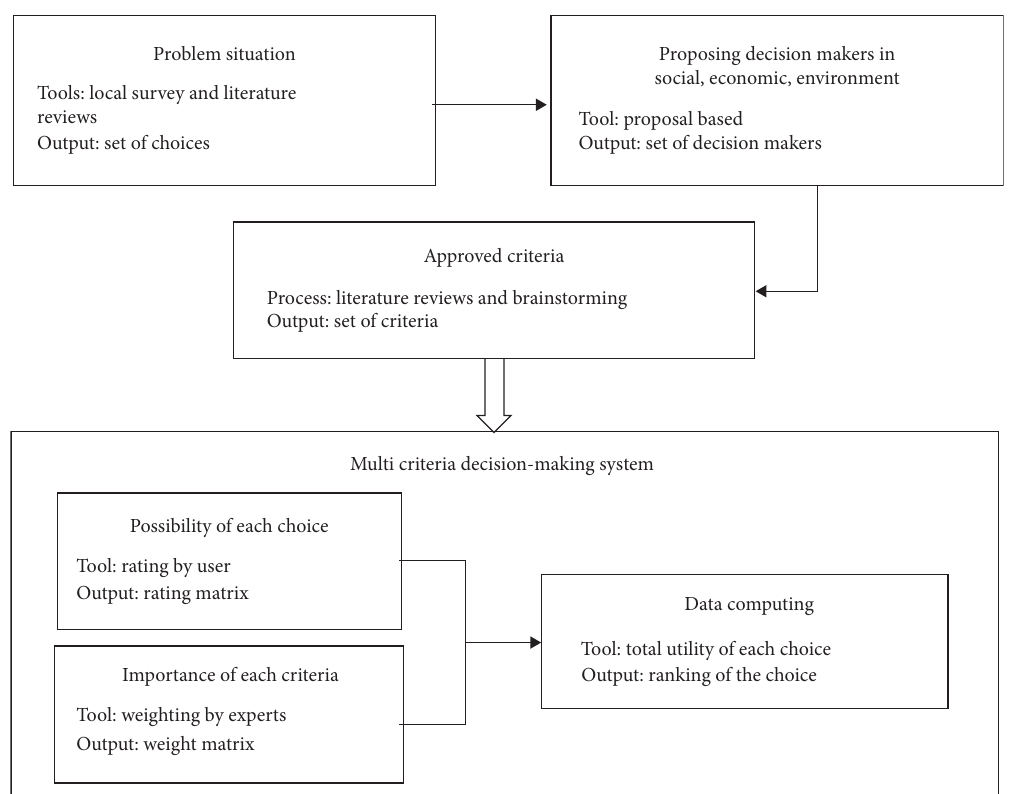
Figure 2: Framework of decision-making process.